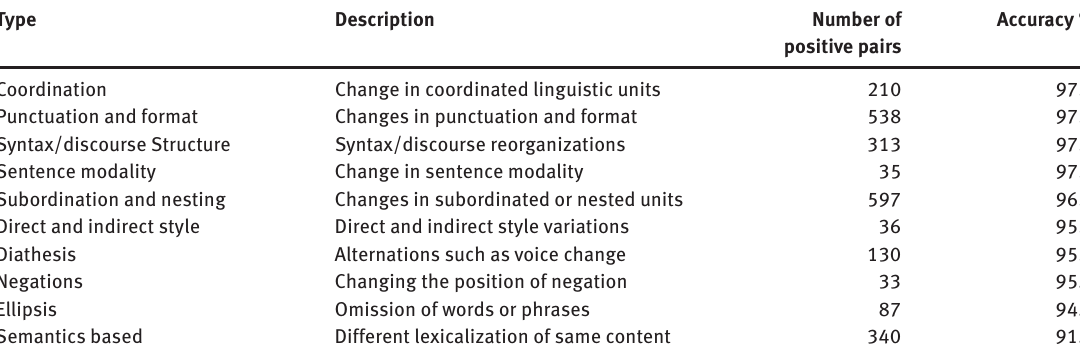
Table 5: Performance on a Subset of the P4P